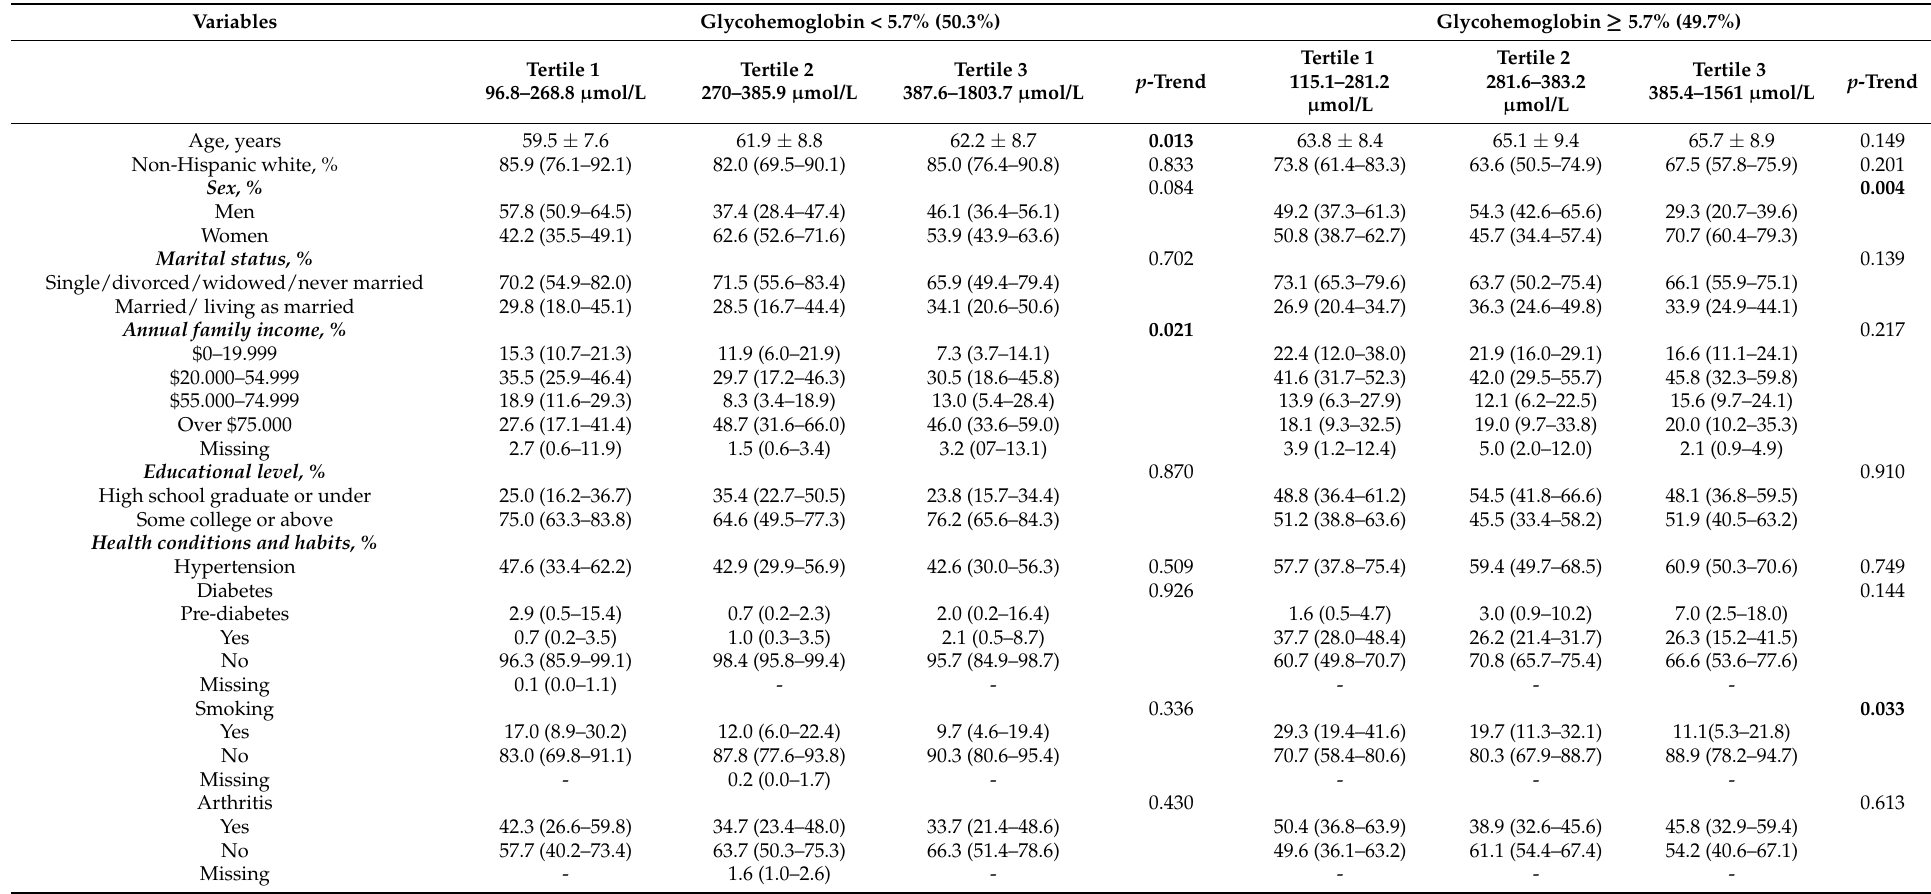
Table 2. Sociodemographic, anthropometric and body composition characteristics in individuals with elevated and normal glycohemoglobin and according to plasma omega-3 tertiles. NHANES,